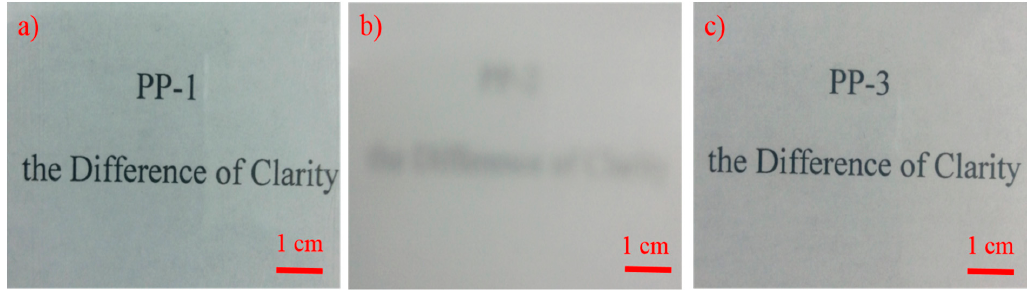
Figure 2. Digital photos comparing the transparency of various polymers (1 mm thick sheet). ( a ) PP-1; ( b ) PP-2; ( c )PP-3. Three samples were determined with 3000 ppm NX 8000 as the nucleating agent.